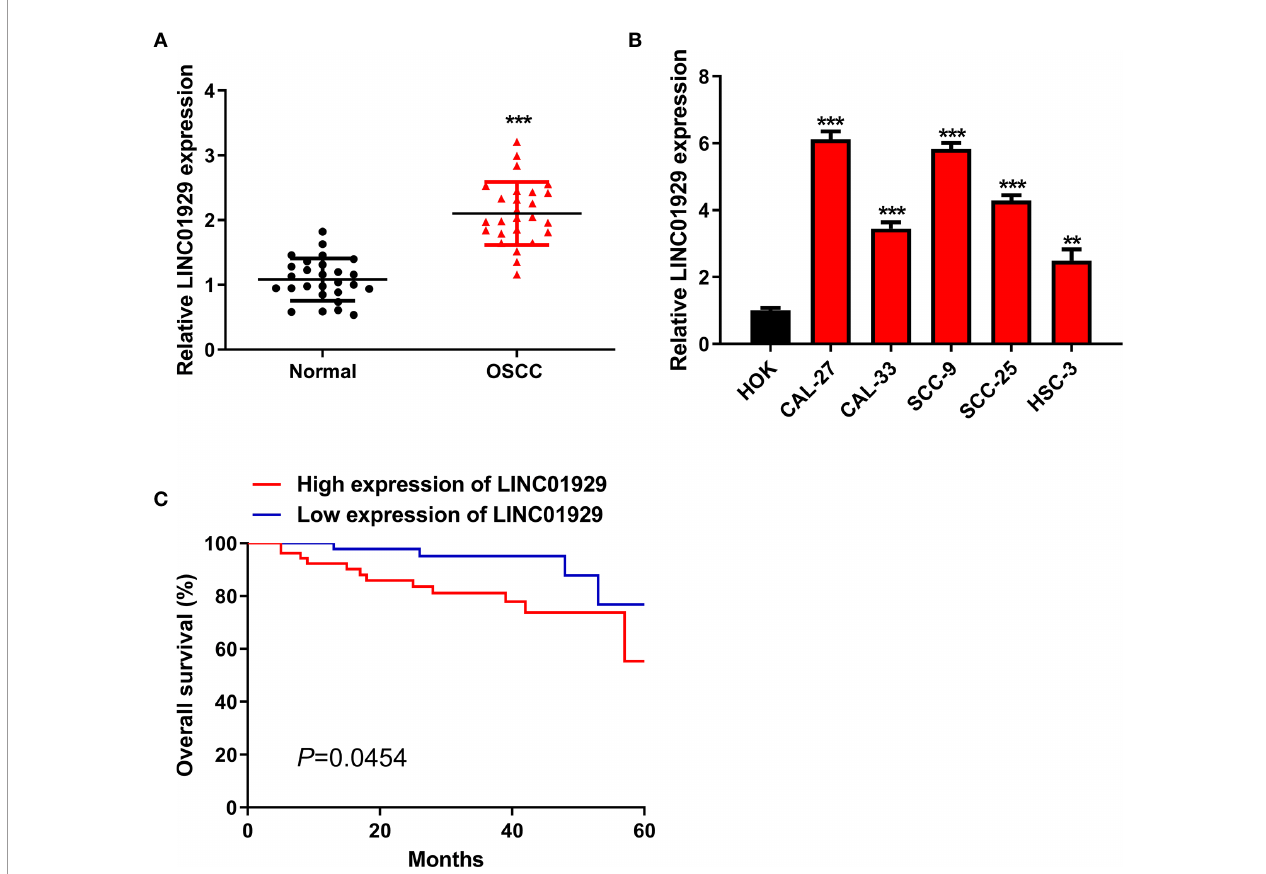
FIGURE 1 | High LINC01929 expression in OSCC tissues and OSCC cells. (A) LINC01929 expression was measured by qRT-PCR in OSCC tissues and paired non-tumor tissues (n = 27). (B) The LINC01929 expression was identi fi ed by qRT-PCR in HOKs and OSCC cells. (C) Survival curves were generated with Kaplan- Meier to measure the correlation between LINC01929 expression and overall survival of OSCC patients. **p < 0.01, ***p < 0.001.